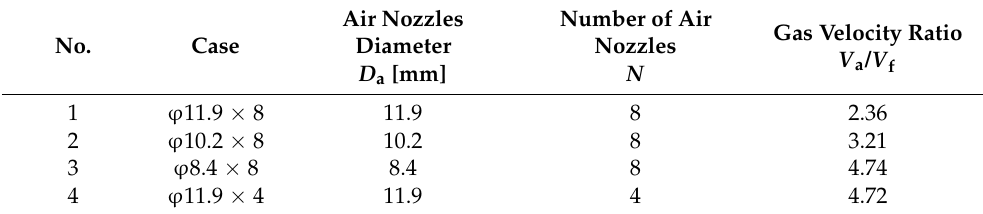
Table 1. Air nozzle